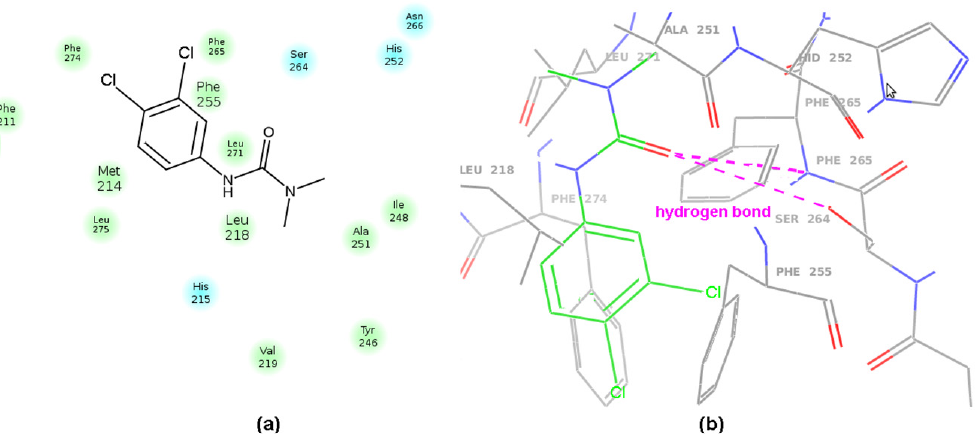
Figure 11. 2D-based ( a ) and 3D-based ( b ) interacting modes of DCMU in the photosystem II (PSII) binding pocket produced by Maestro software.